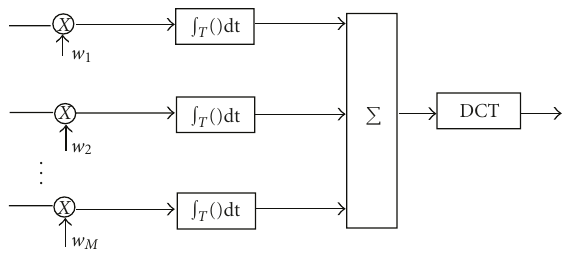
Figure 6: Echo combining by clusterhead in